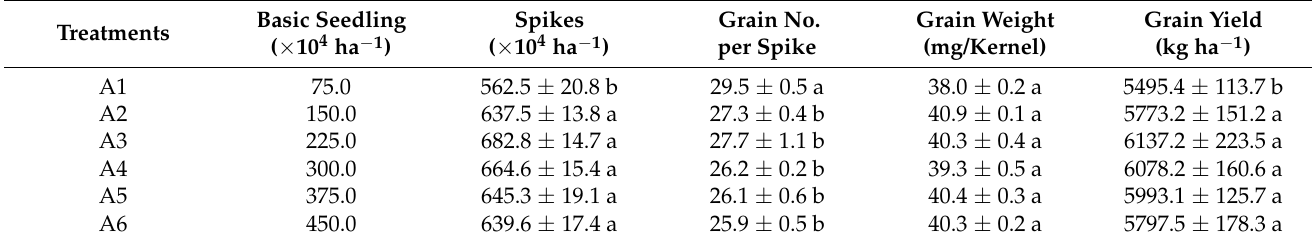
Table 5. Yield components of hybrid wheat in different density treatments.